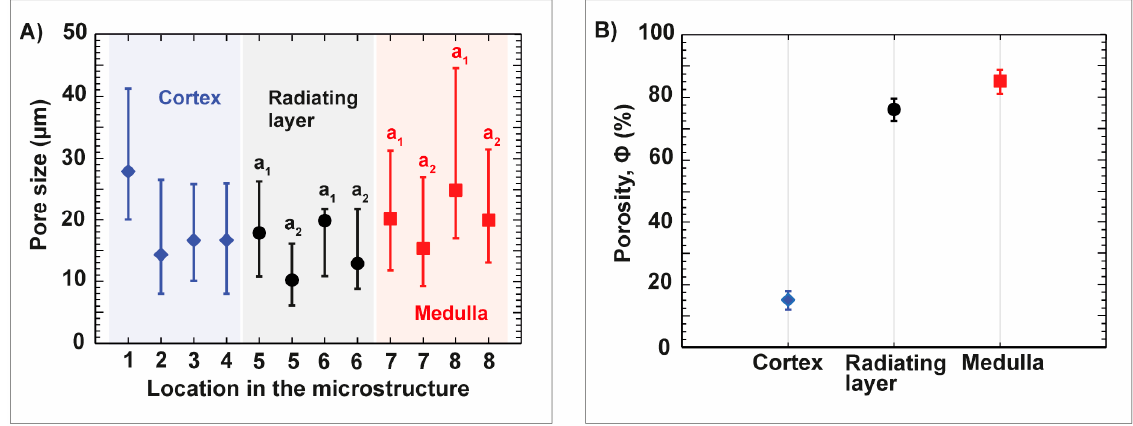
Figure 8. Characterization of the pore sizes and porosities of the microstructural units (cortex, radiating layer and medulla) in the spine of Phyllacanthus imperialis . The pore axis length is shown by a 1 and a 2 , and of the structures forming the radiating layer, the medulla and the cortex are displayed in ( A ). The location within the spine microstructure is given as numbers. The affiliation of the numbers is shown in Figure 5 B and Figure 7, respectively. The plot in ( B ) represents the average porosities of the cortex, radiating layer and medulla.